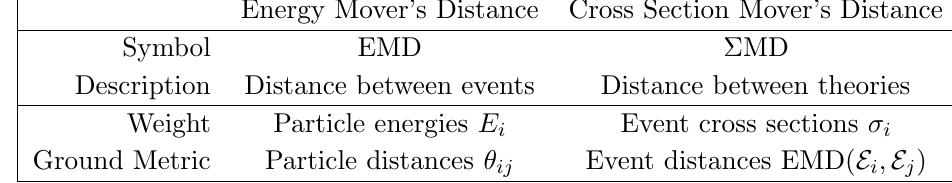
Table 2 . Comparing the constructions of EMD and (cid:6)MD as optimal transport problems. Events are treated as energy-weighted angular distributions, whereas theories are treated as cross section- weighted event distributions. This connection allows us to bootstrap the EMD as a ground metric for the (cid:6)MD to develop a rigorous notion of theory